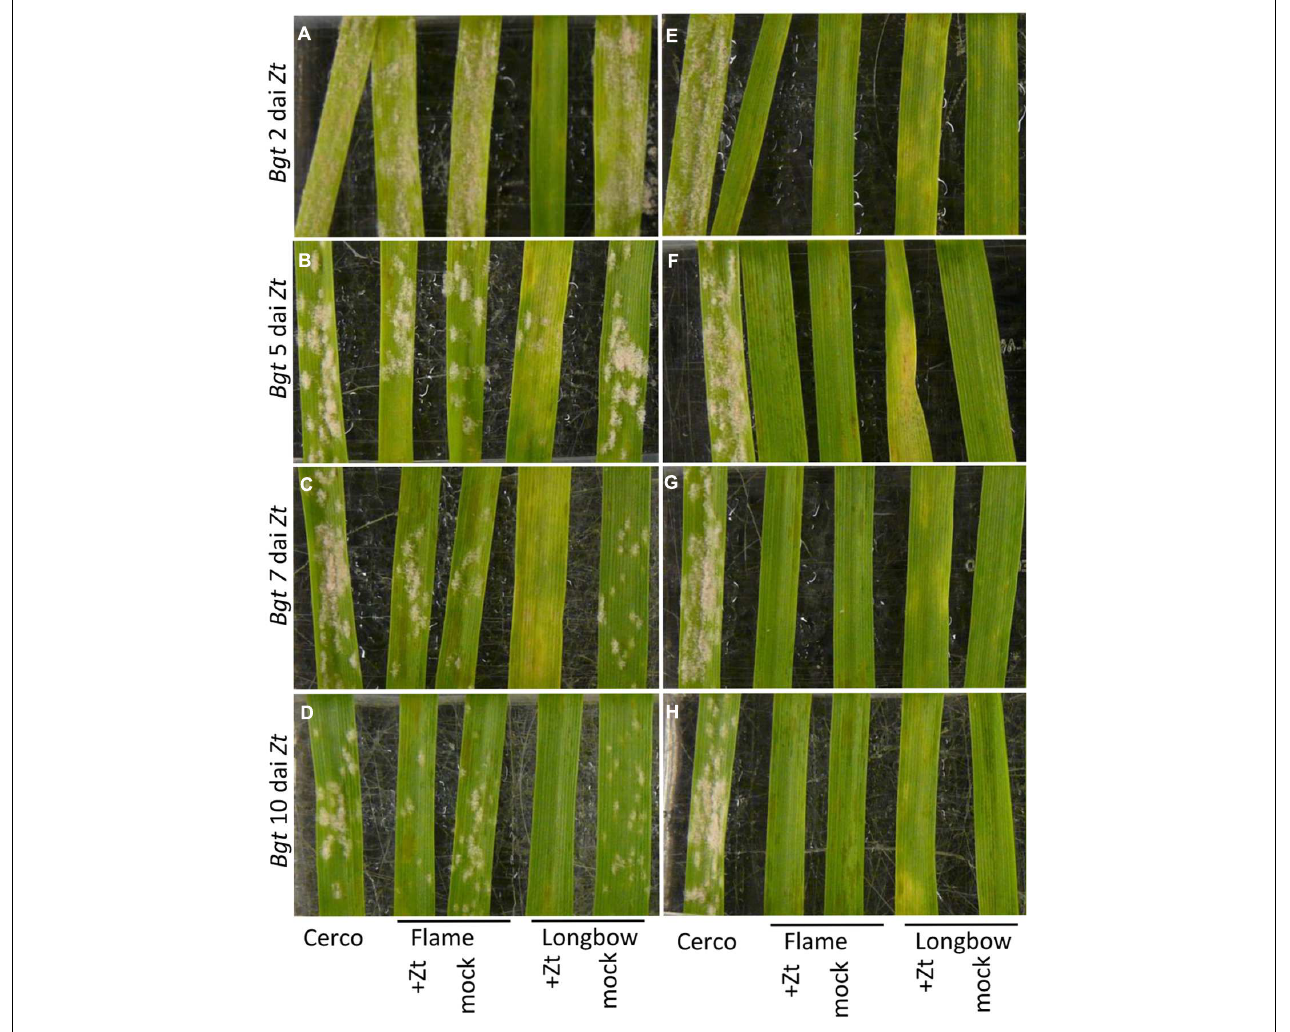
FIGURE 2 | Leaves of wheat varieties Flame and Longbow inoculated first with Z. tritici isolate IPO323 then with either avirulent or virulent isolates of B. graminis f.sp. tritici ( Bgt ). Order of leaves in each photograph (L to R): Cerco, Flame + IPO323, mock-inoculated Flame, Longbow + IPO323, Longbow mock. (A–D) Inoculated with virulent Bgt isolate JIW48. (E–H) Inoculated with avirulent Bgt isolate JIW11. Leaves were inoculated with Bgt 2 days after inoculation (dai) with Z. tritici (A,E) , 5 dai (B,F) , 7 dai (C,G) or 10 dai (D,H) . Photographed 20 days after inoculation with Z. tritici .